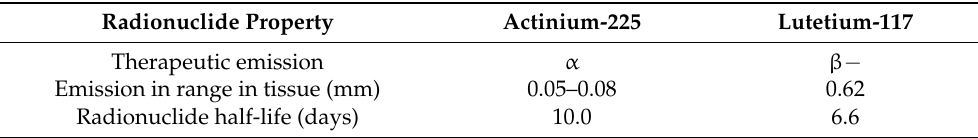
Table 1. Radionuclide properties of Actinium-225 and Lutetium-177. Reference: Sgouros G, Nature reviews (2020); 589–608